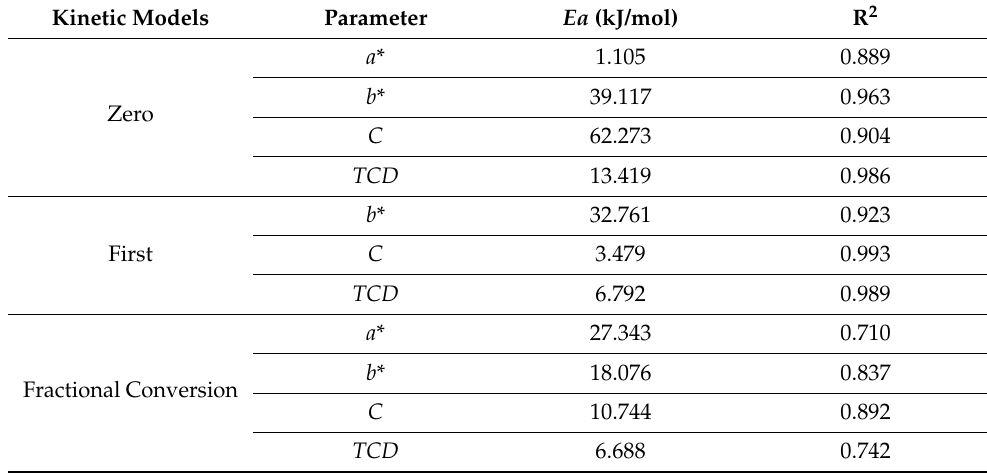
Table 3. The activation energy and coefficient of determination (R 2 ) of the kinetic models (zero, first, and fractional conversion) according to the changes of color parameters ( a *, b *, C , and TCD ) and texture (firmness) of Dabai fruit due to